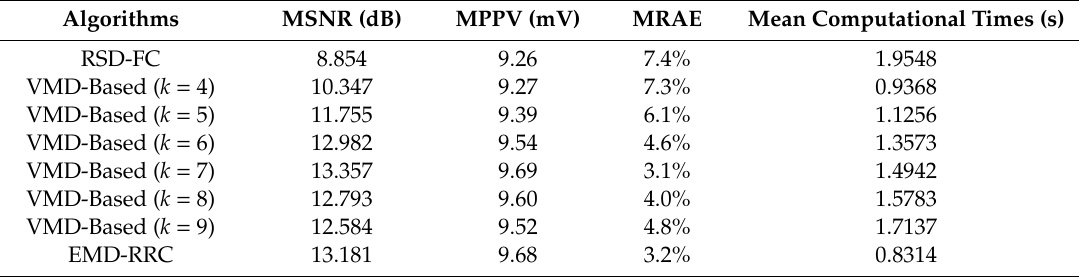
Figure 8. The extraction results of different algorithms applied on the preliminarily extracted signals. ( a ) resonance-based signal decomposition method and fractional calculus (RSD-FC), ( b ) variational mode decomposition (VMD)-based method with k = 7, ( c ) empirical mode decomposition and reverse reconstruction (EMD-RCC). Table 2. Computational times and the performance of different algorithms.